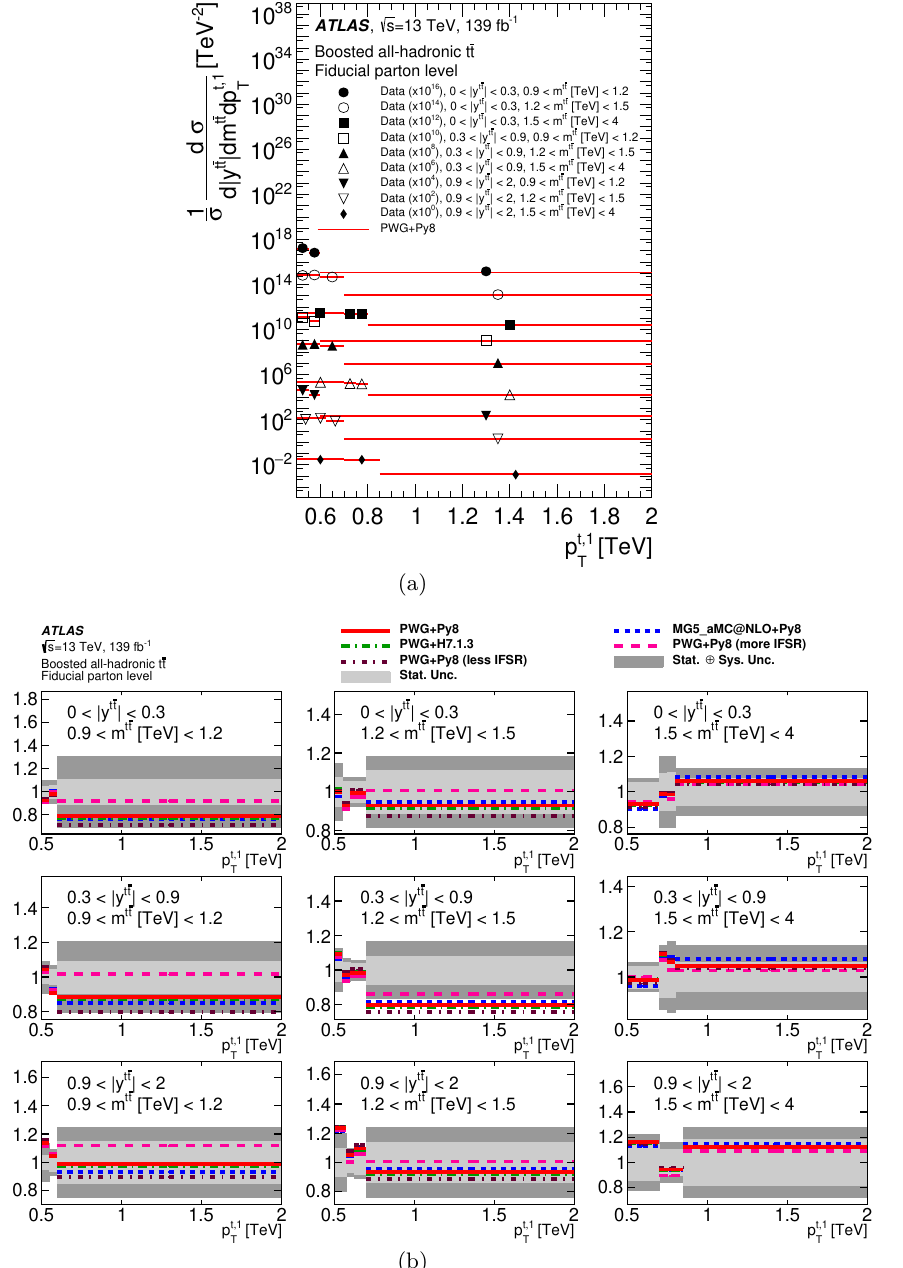
Figure 32 . (a) Normalized parton-level fiducial phase-space triple-differential cross-sections as a function of the absolute value of the rapidity of the t ¯ t system, and the p T of the leading top quark, compared with the Powheg+Pythia 8 calculation. Data points are placed at the centre of each bin and the Powheg+Pythia 8 calculation is indicated by solid lines. The measurement and the prediction are normalized by the factors shown in parentheses to aid visibility. (b) The ratios of various MC calculations to the normalized parton-level fiducial phase-space differential cross-sections. The dark and light grey bands indicate the total uncertainty and the statistical uncertainty, respectively, of the data in each